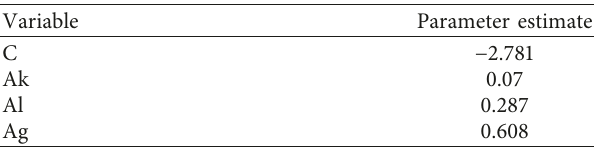
Table 10: Parameter estimates of transcendental logarithm pro- duction function based on principal component